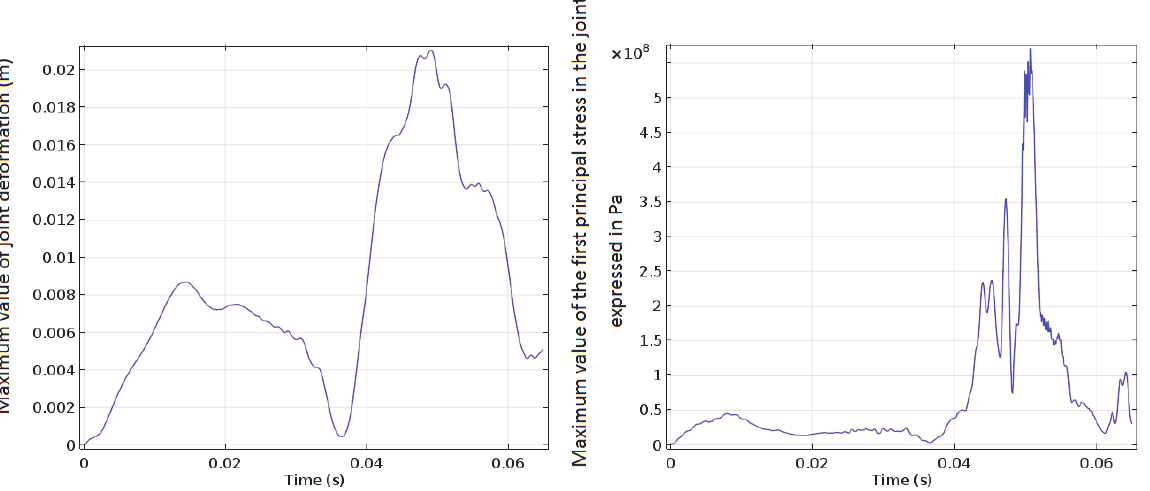
Fig. 6: Time evolution of the maximum values of: a) joint displacement (and so elongation) and (b) First principal stress. The values are calculated in a joint cross-section located in the middle of the longer side of the